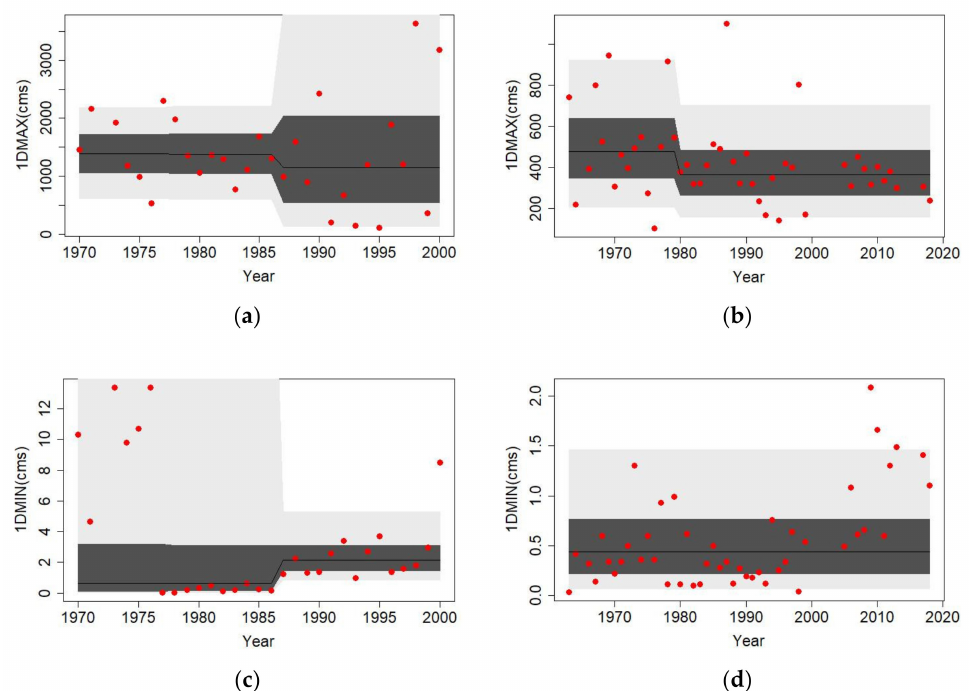
Figure 6. Variations of quantile curves (0.95, 0.75, 0.5, 0.25, and 0.05 from top to bottom) of 1DMAX (annual maximum 1-day streamflow) at ( a ) H5 (Xiulang) and ( b ) H7 (Wudu), and 1DMIN (annual minimum 1-day streamflow) at ( c ) H5 (Xiulang) and ( d ) H7